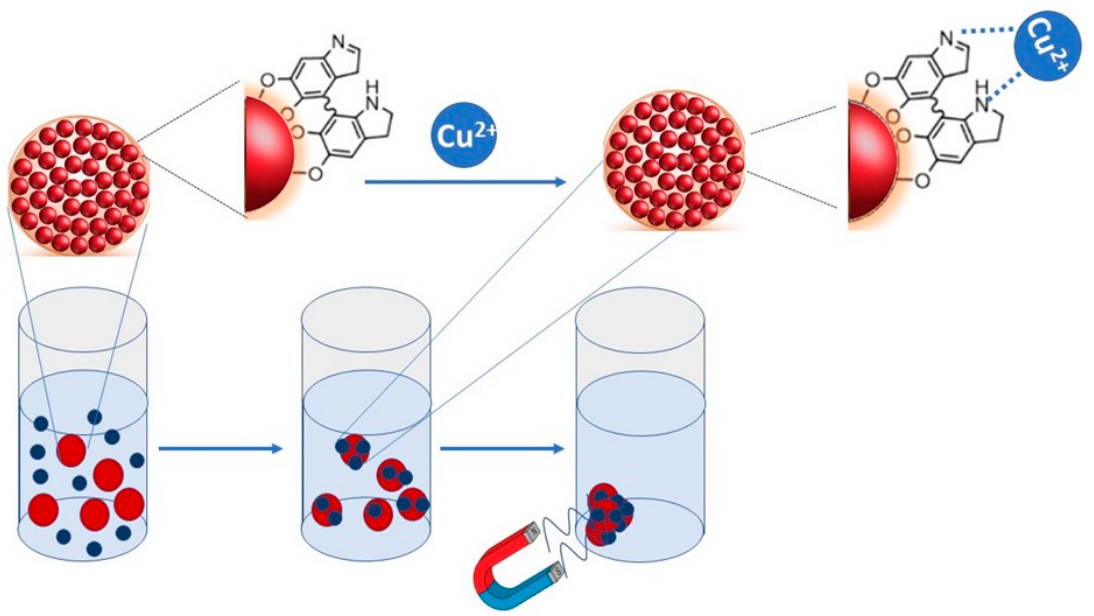
Figure 1. Sketch depicting the adsorption mechanism and the polyvalent coordination of copper due to PDA interaction.